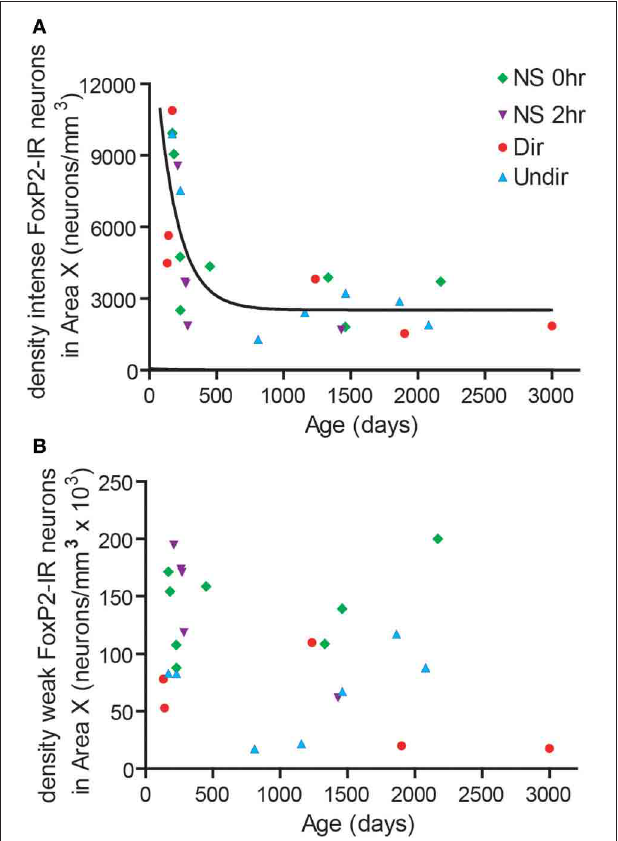
FIGURE 4 | FoxP2 expression was higher in younger adults than in older adults. (A) The density of intensely-stained FoxP2-IR neurons followed a one-phase decay relationship relative to age in days ( R 2 = 0 . 5437). (B) The density of weakly-stained FoxP2-IR bore no relationship with age ( R 2 = 0 .